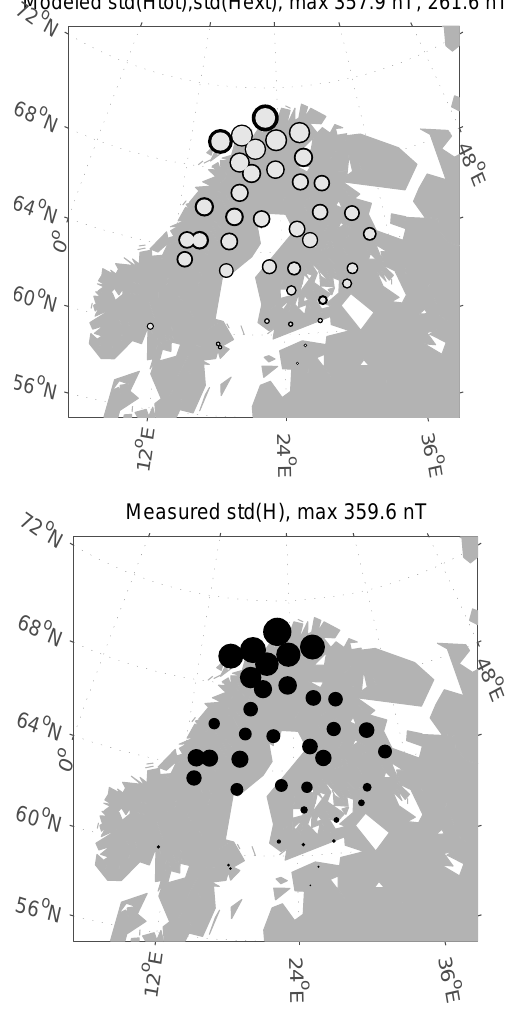
Fig. 5. Standard deviations of the modeled and the measured hori- zontal magnetic field variations. Light and black circles on the top panel correspond to standard deviations of the external field and the total field, respectively. The maximum standard deviations are indi- cated in the titles of the figures.